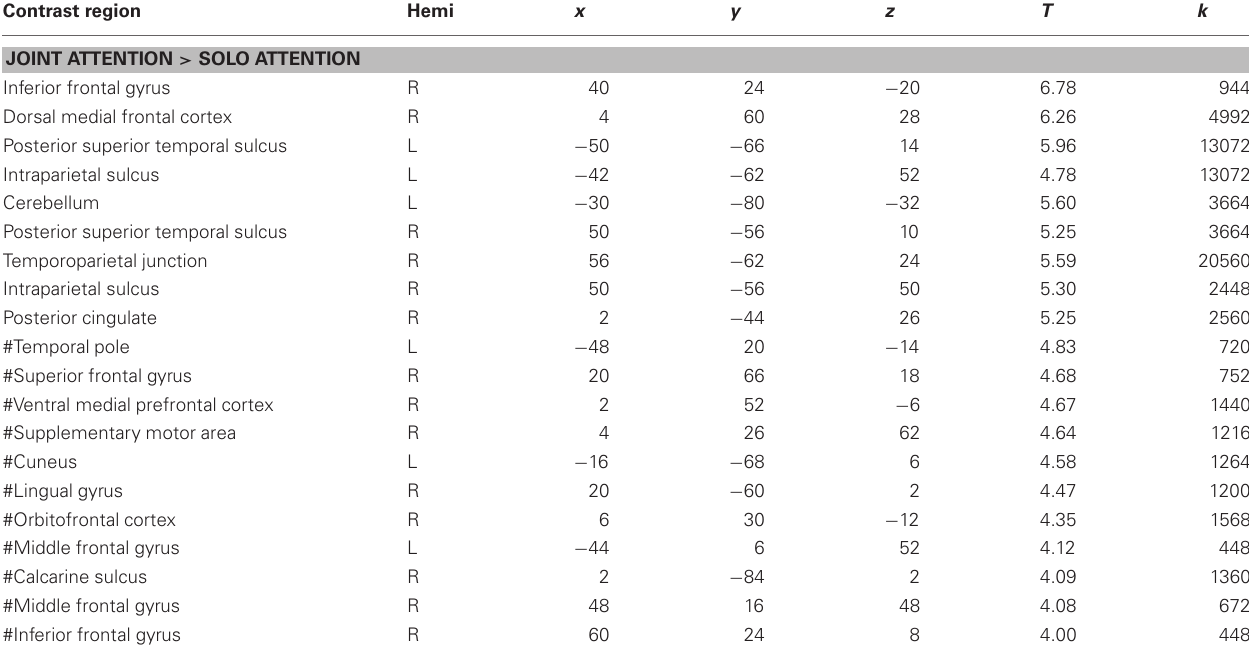
Table 3 | Seed regions for functional connectivity analyses. Contrast